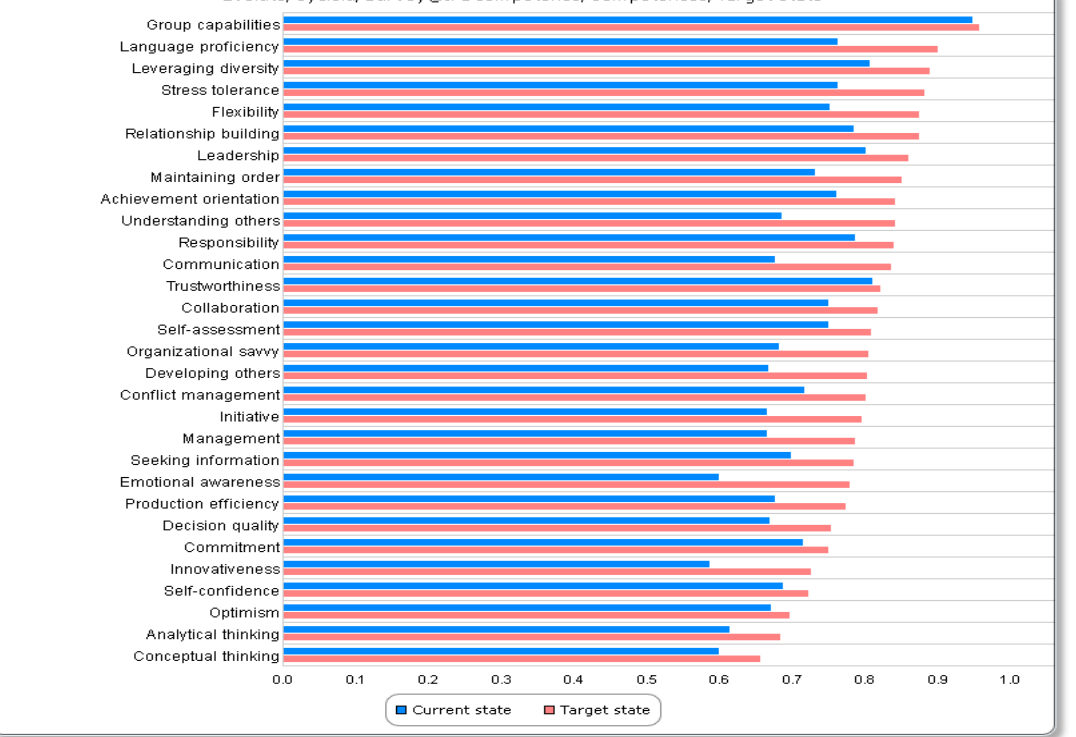
Table 8. The ranking of 10 creative tension competencies.